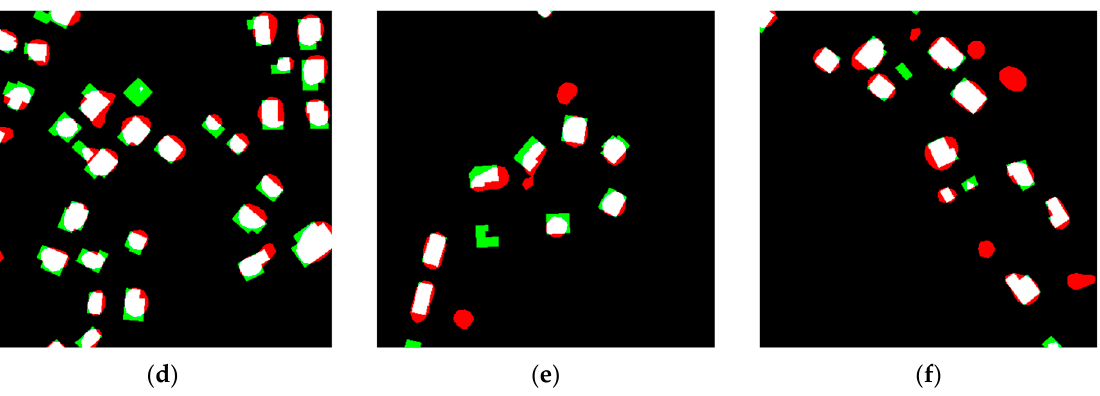
Figure 10. Examples of the original images ( a – c ) and results of their inference results compared to the ground truth ( d – f ). White color represents the match between ground truth and inference, green represents the ground truth which is not covered by the inference results, and red represents the inference results which do not cover ground truth.